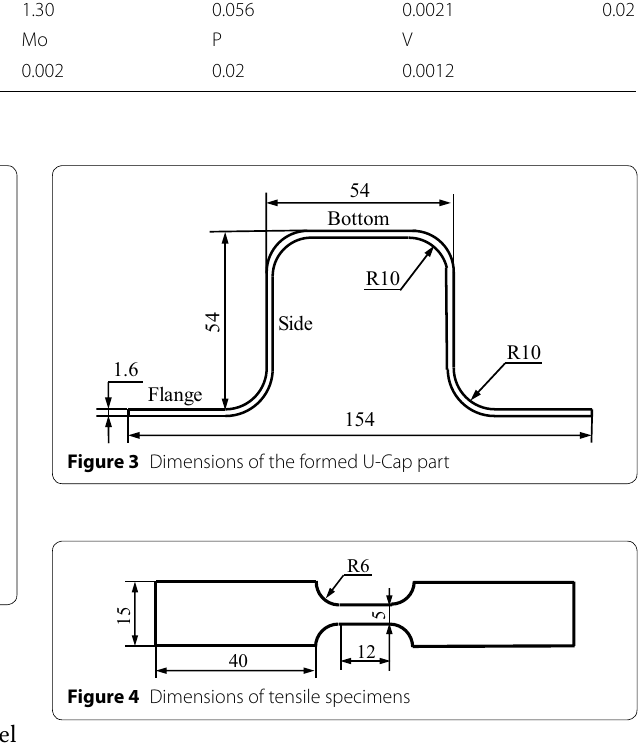
Table 2 Chemical compositions (wt.%) of the B1500HS steel Material